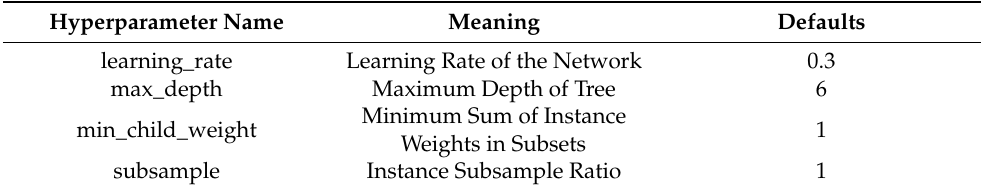
Table 1. Descriptions and default values of XGBoost hyperparameters.